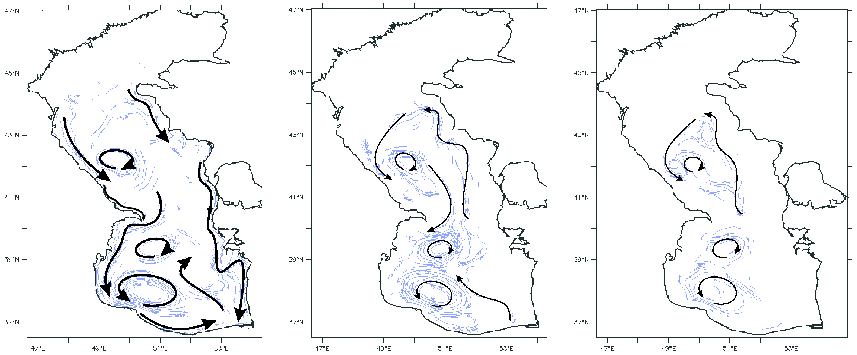
Figure 13. Schematic representation of the annual mean circulation of the Caspian Sea for the depth ranges (left panel) surface (0–10m), (middle panel) intermediate (50–100m) and (right panel) deep